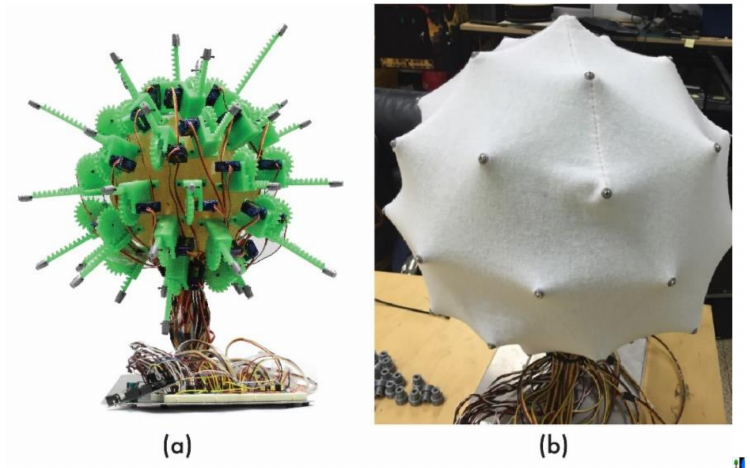
Figure 11. Lycra screen placed over the poles of radially arranged actuating pins to form a screen: ( a ) internal hardware and ( b ) formation of concave shapes due to tension in the screen